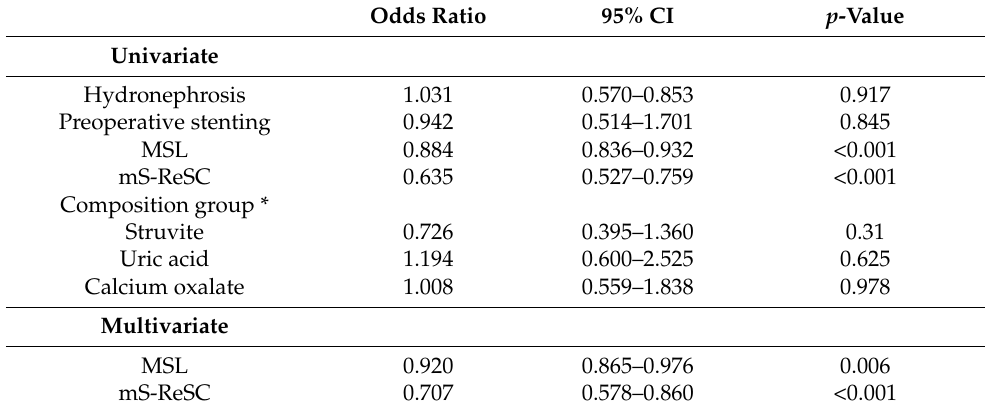
Table 3. Logistic regression models for predicting stone-free rate according to test parameters. Odds Ratio 95% CI p